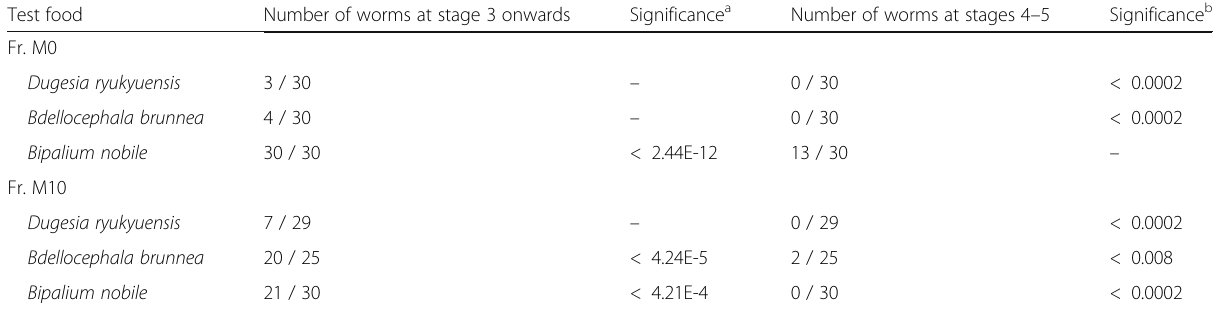
Table 2 Comparative analysis of sex-inducing activity after the point-of-no-return Test food Number of worms at stage 3 onwards